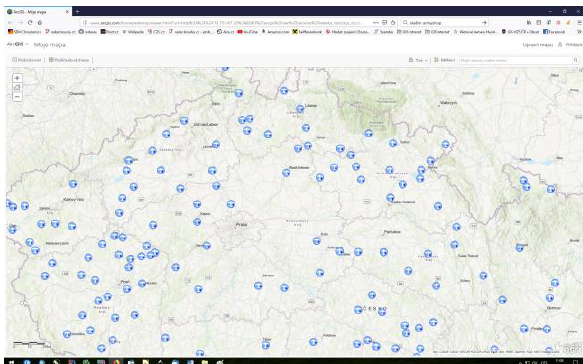
Figure 4. The preview of the created service of selected places for water supply in the ArcGIS Online map